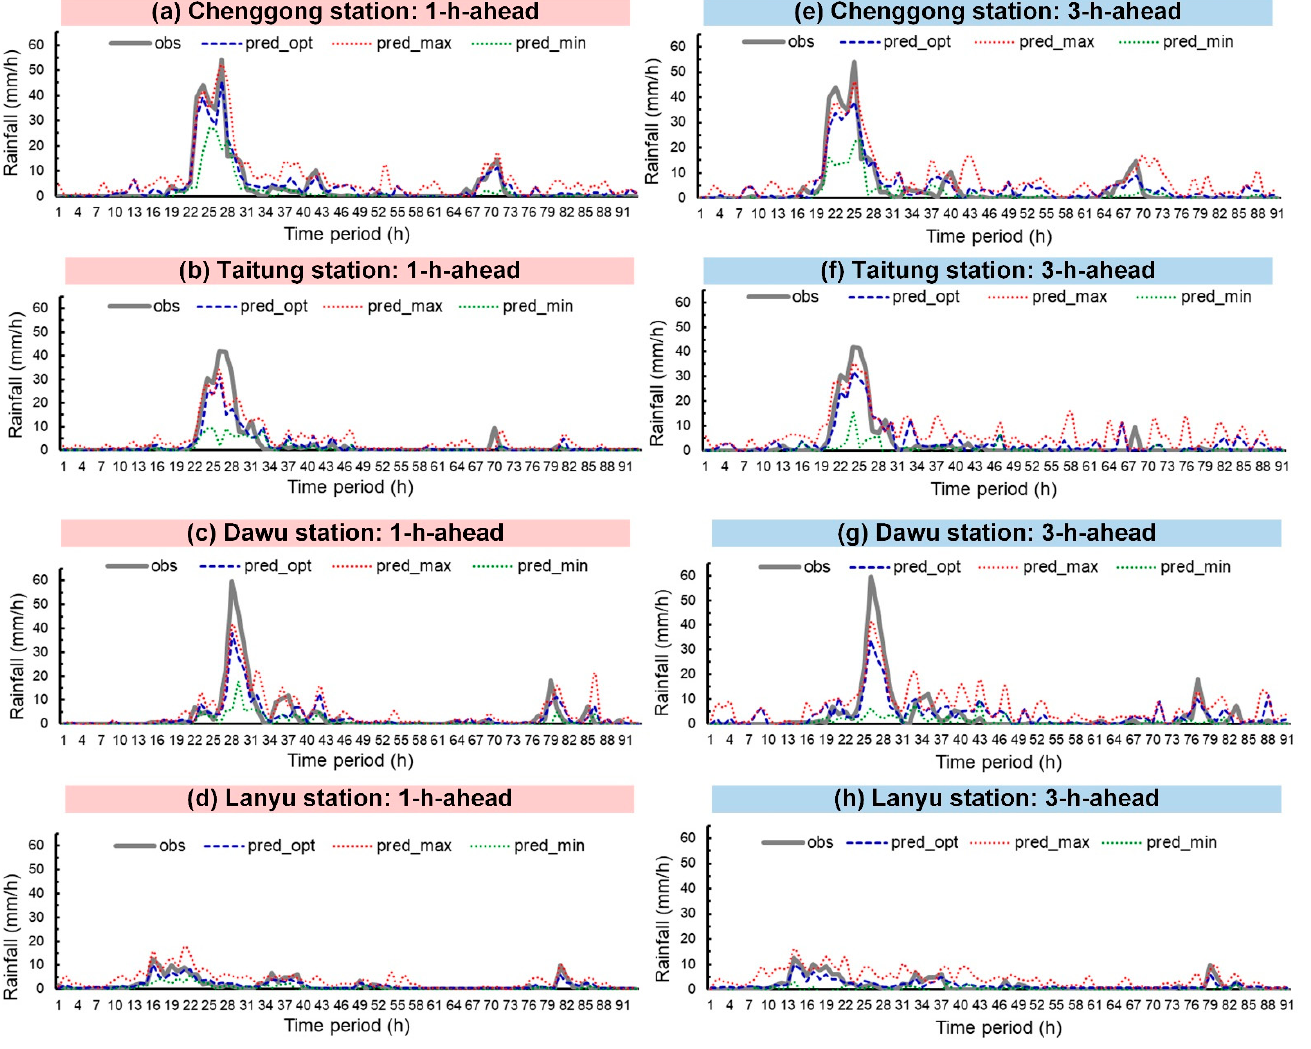
Figure 8. Typhoon Nepartak prediction results: ( a – d ) lead time = 1 h; ( e – h ) lead time = 3 h.